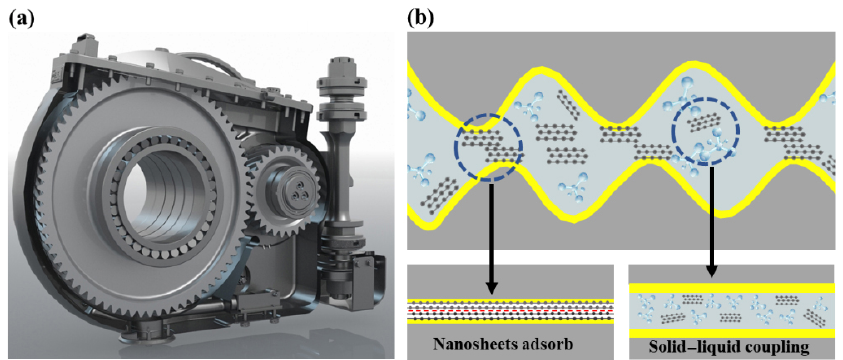
Fig. 14 Two-dimensional material nanosheets improve superlubricity state stability. (a) High-speed rail gear transmission system and (b) nanosheet